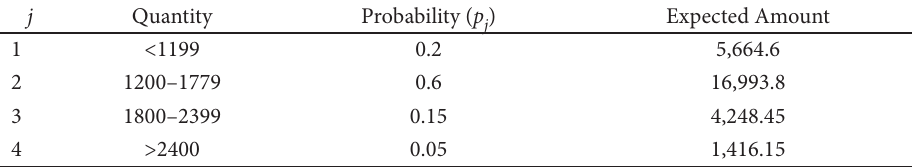
Table 6. Expected total sales amounts of the